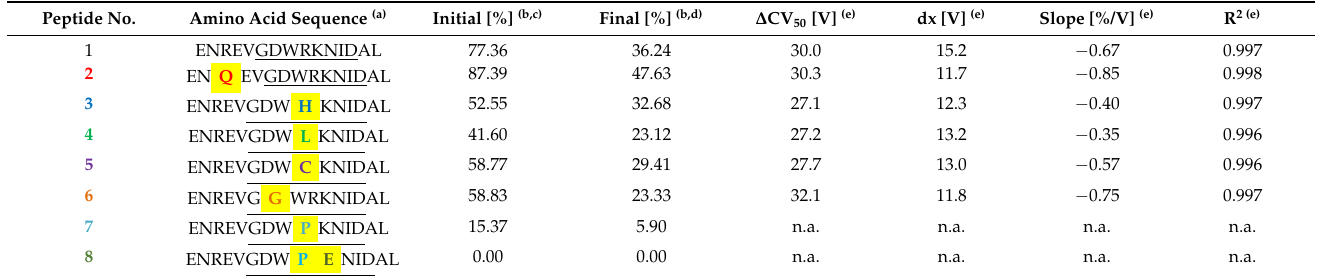
Table 2. Course characteristics of gas phase dissociations of the immune complexes of hcTn I epitope peptides and anti-hcTn I